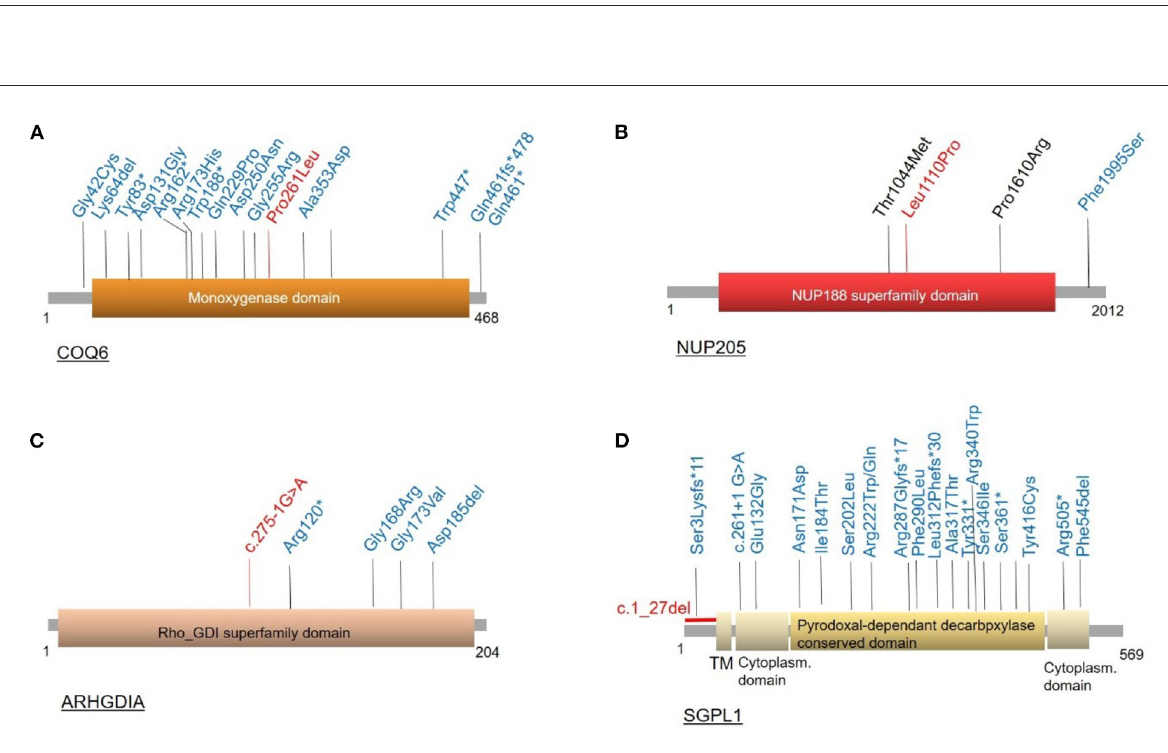
in NPHS1 , NPHS2, and NPHP1 (45%), one allele was a − 1 canonical splice site variant in ARHGDIA , one a + 2 splice site variant in NPHS1 classified as likely pathogenic according to ACMG criteria, one small deletion causing a start loss in SGPL1 , and the remaining variants were missense variants.